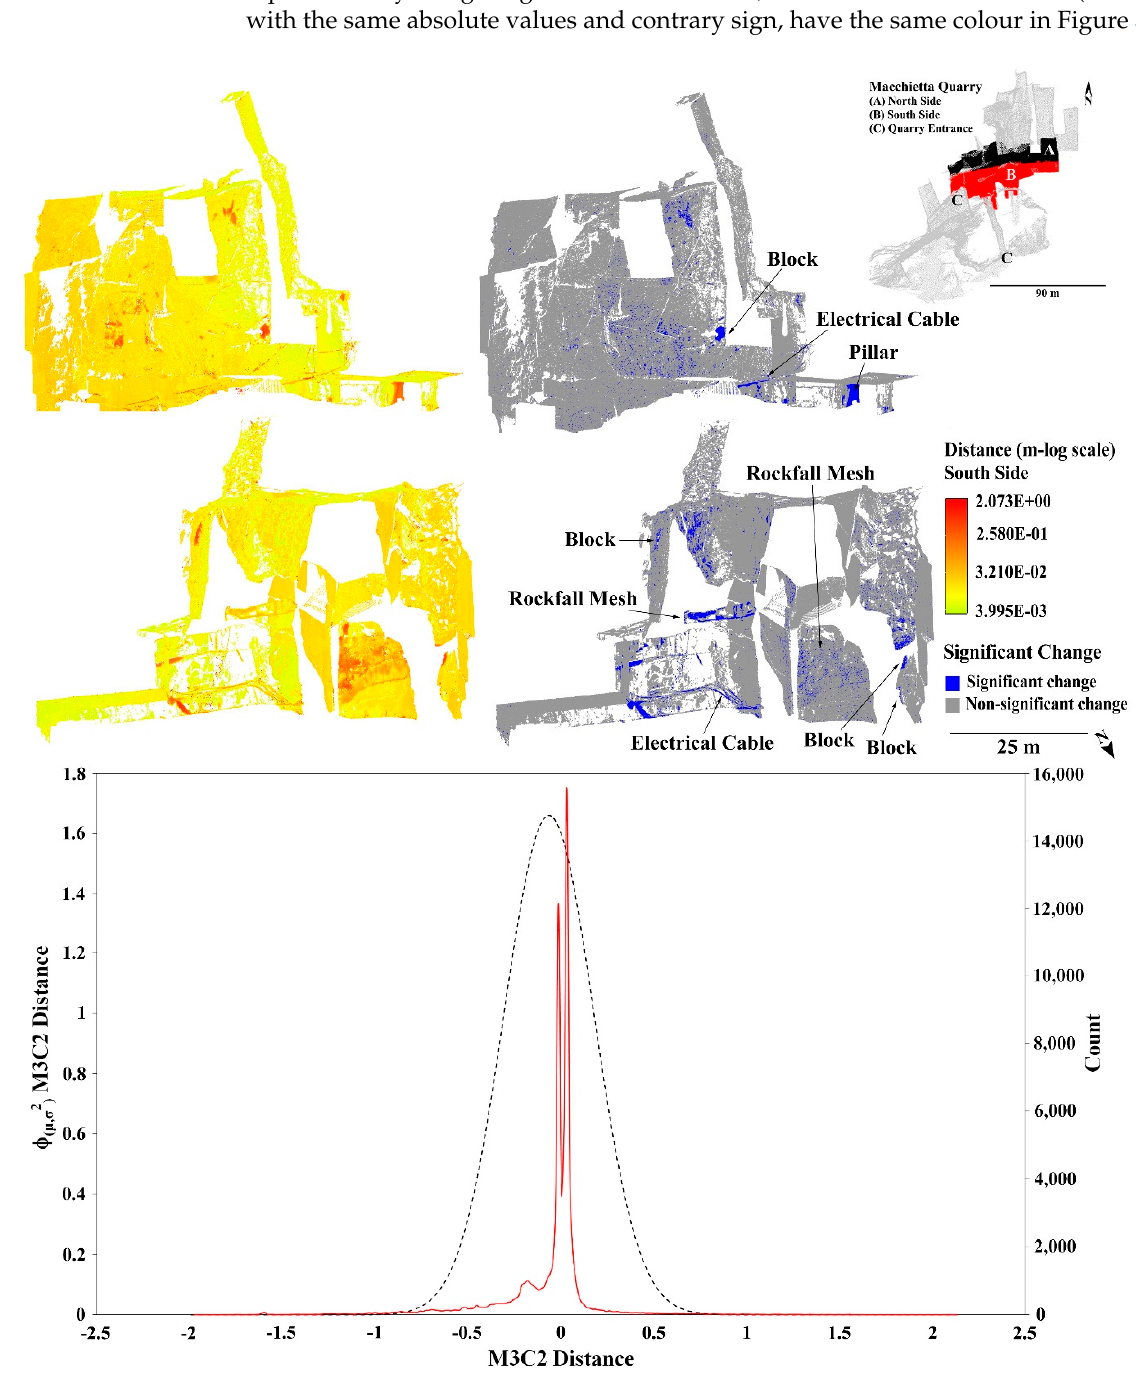
Figure 5. Maps of computed distance ( left ) and significant change ( right ) of the Northside of the quarry (A) and Southside of the quarry (B). The points of view are indicated by the north arrows. The scale bar is indicative only due to the perspective view. The inset map represents the top view of the Macchietta quarry with highlighted the North (A) and South (B) sectors. At the bottom (C), the Gaussian distribution of the computed distances ( φ ( µ , σ 2 ) -dotted line) corresponding to significant changes for the whole underground quarry.